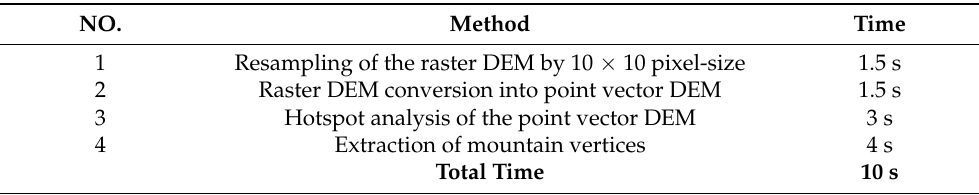
Table 5. The time consumed in extracting mountain vertices for the first dataset using our pro- posed approach.